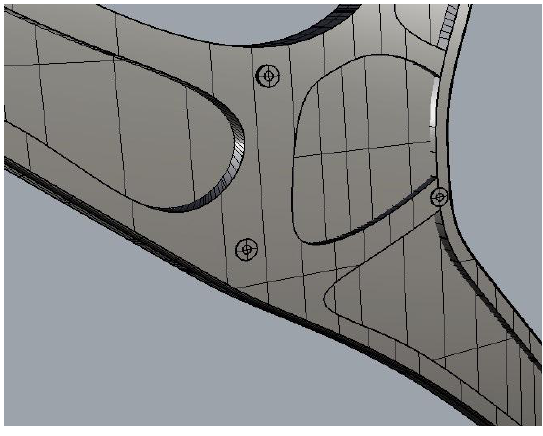
Figure 29. Structure of hollows.